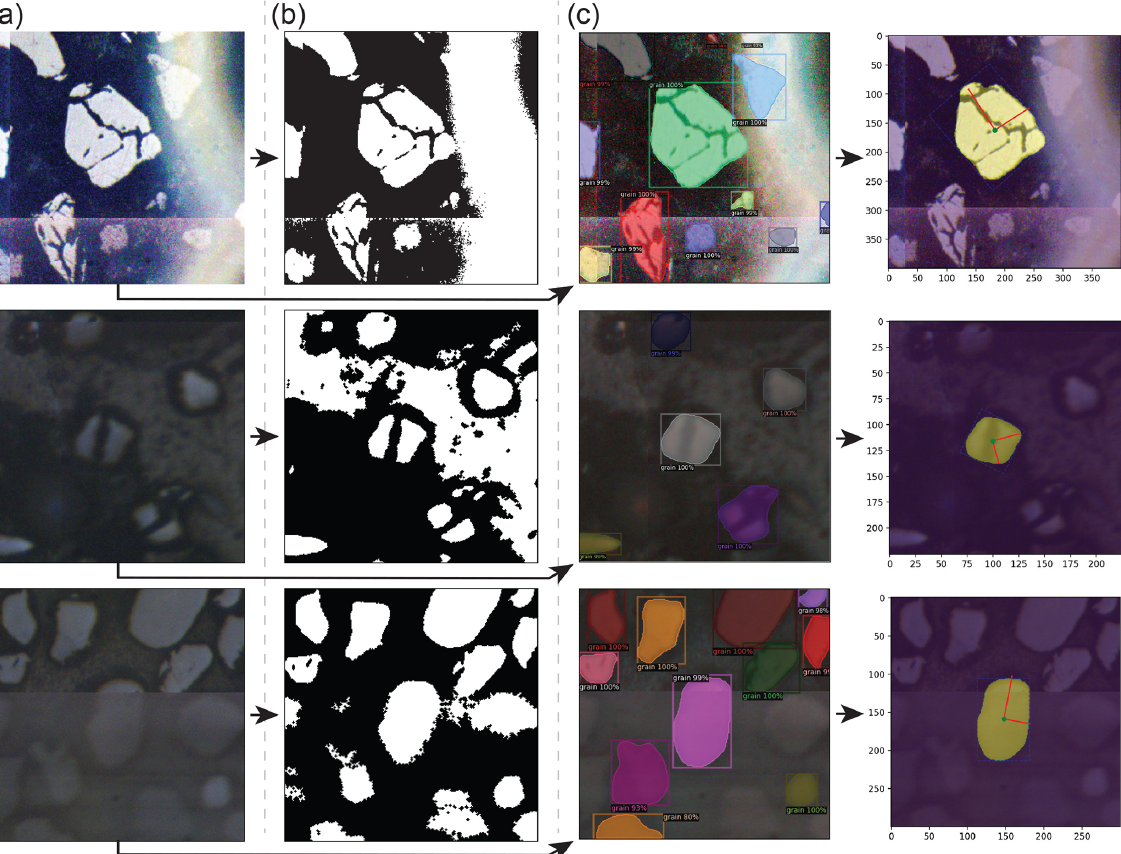
Figure A1. Comparison between Otsu thresholding and convolutional neural network (CNN)-based instance segmentation results in the presence of diverse grain morphologies and image artefacts, including anomalous bright spots (top row), heavily fractured grains (middle row), and tiling artefacts (bottom row). (a) Original grain-centred images clipped from ALC mosaics. (b) Segmentation masks produced via Otsu’s thresholding method (Otsu, 1979). (c) Instance segmentation results produced by a Mask-RCNN model (M-ST-C) (left column) and resulting colab_zirc_dims verification image plots (right